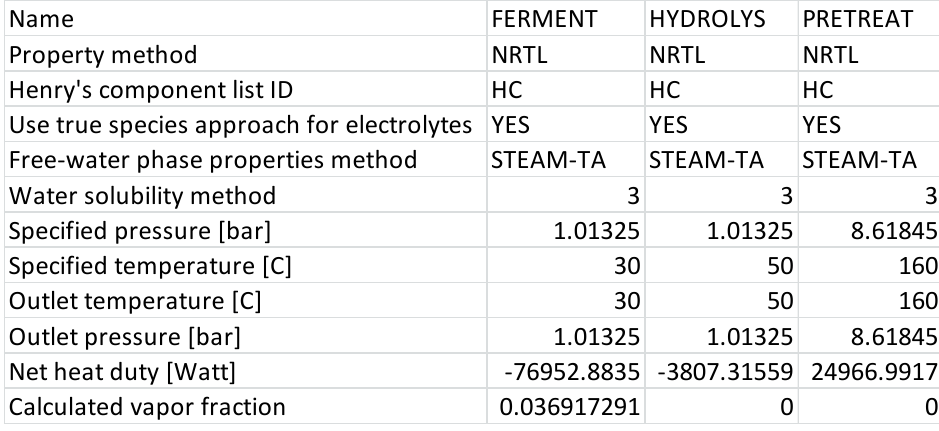
Figure A15. Fermentation ferment, hydrolys, pretreat reactor